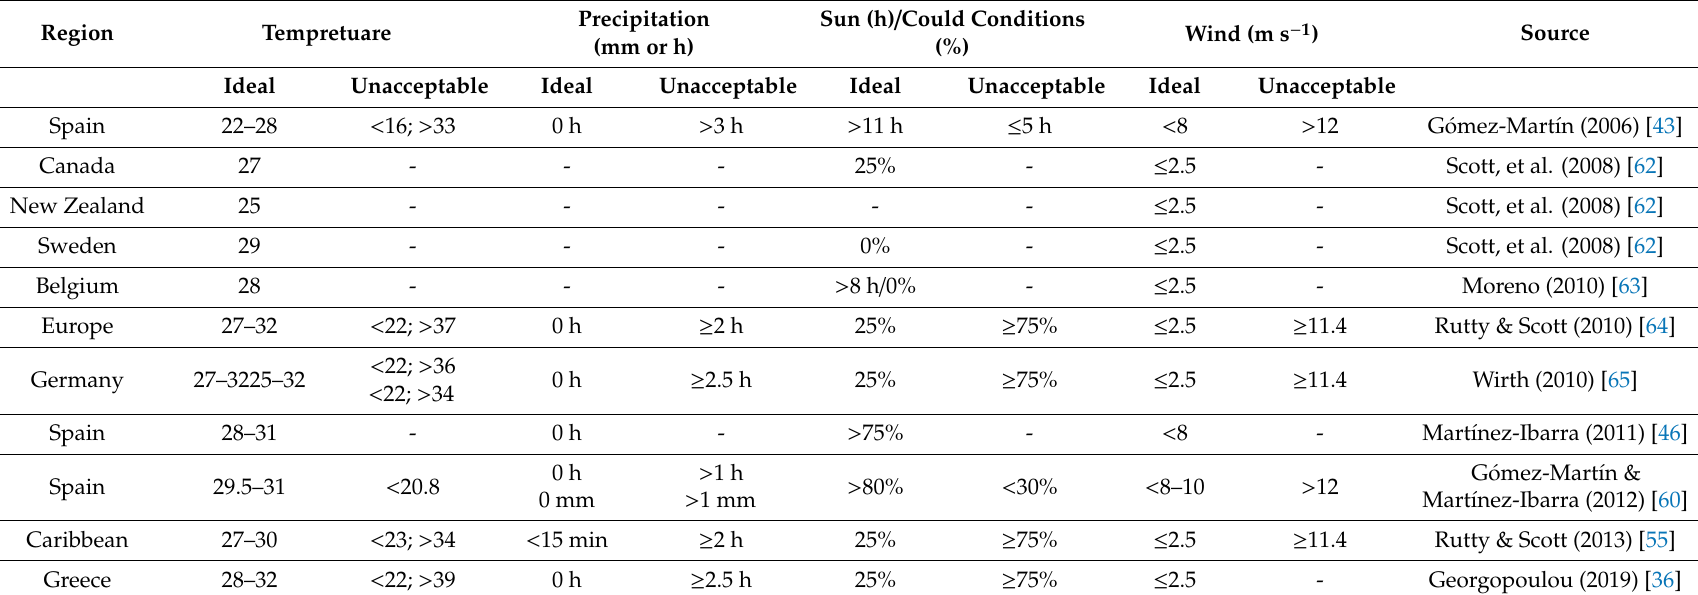
Table 1. Daily climatic (ideal / unacceptable) threshold conditions for beach